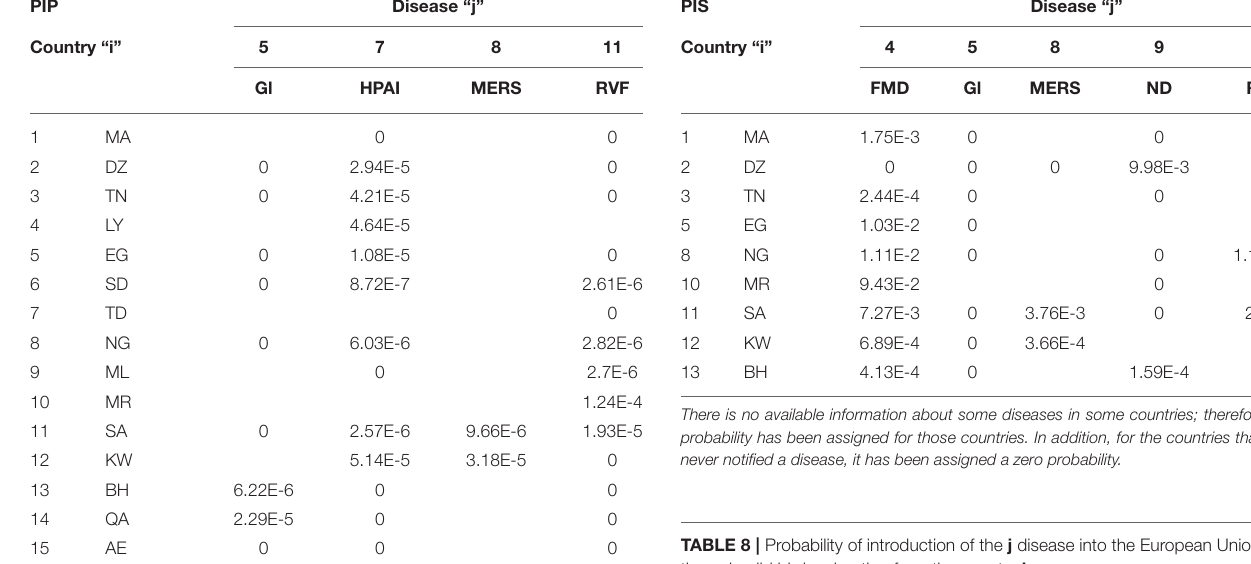
TABLE 7 | Probability of introduction of the j disease into the European Union through importation of animal products from the country i . PIS